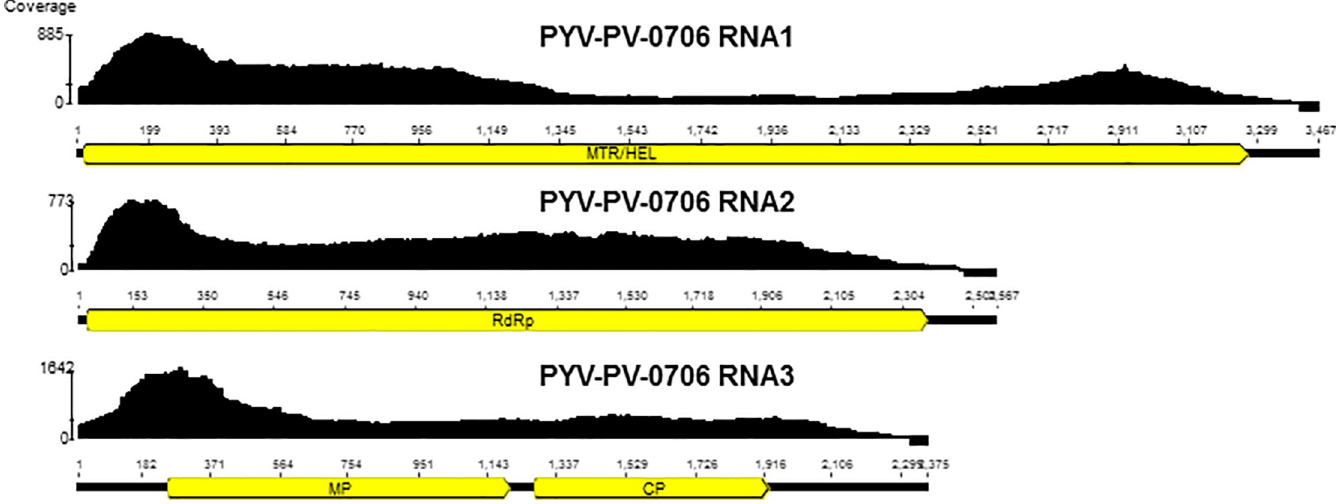
Fig 1. PYV genome organization and coverage with reads from